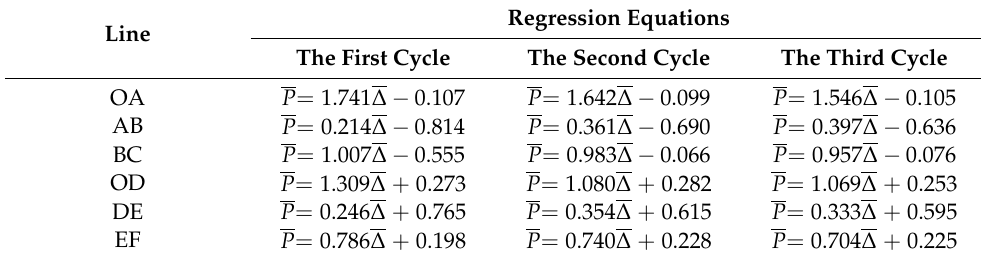
Table 5. Equations of the envelope curves of the Kanchuang frame.